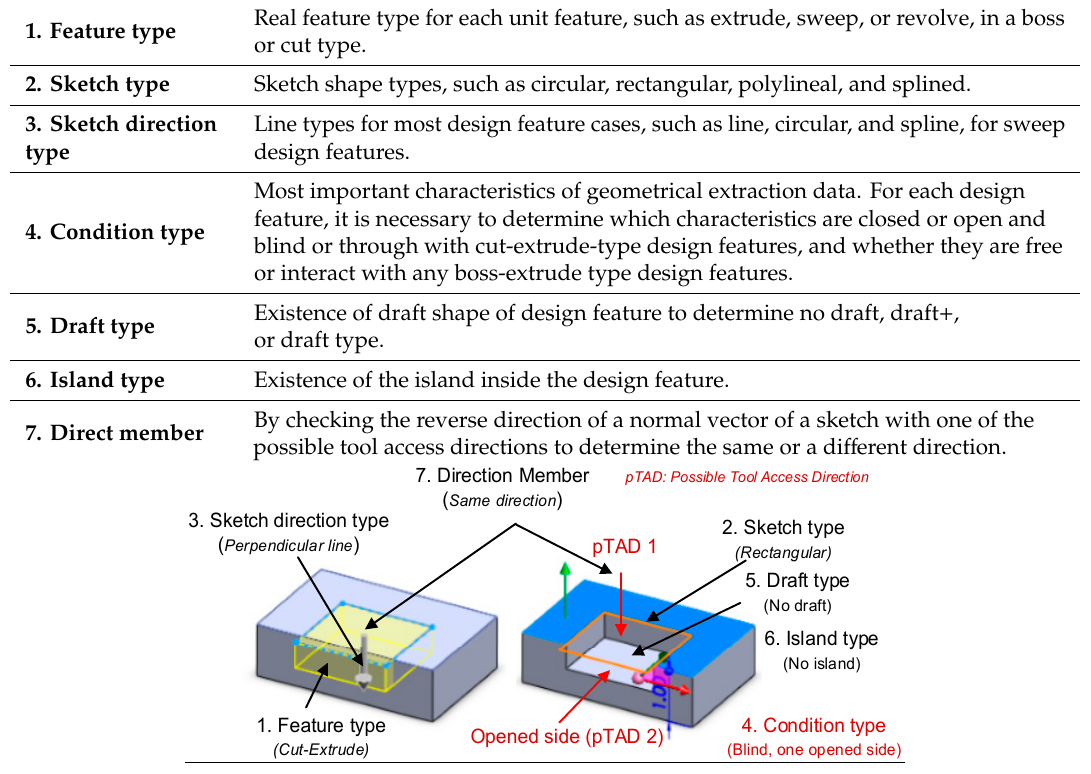
Table 1. Definition of seven geometrical data extraction types.